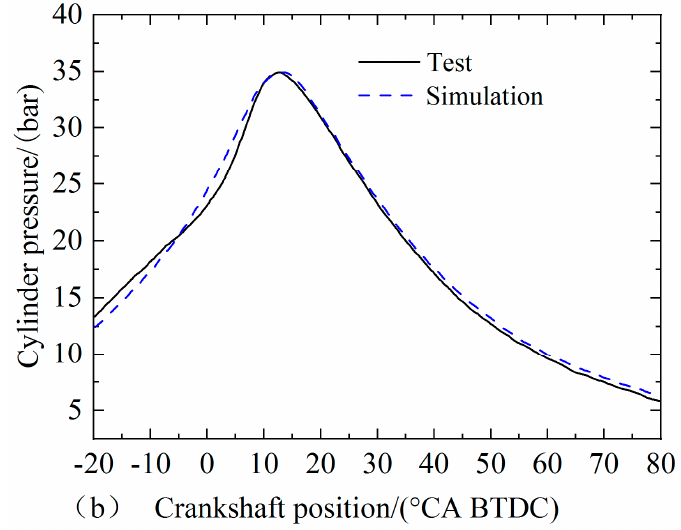
Figure 6. Validation of the calculation model with the test data: ( a ) engine output; ( b ) combustion pressure.